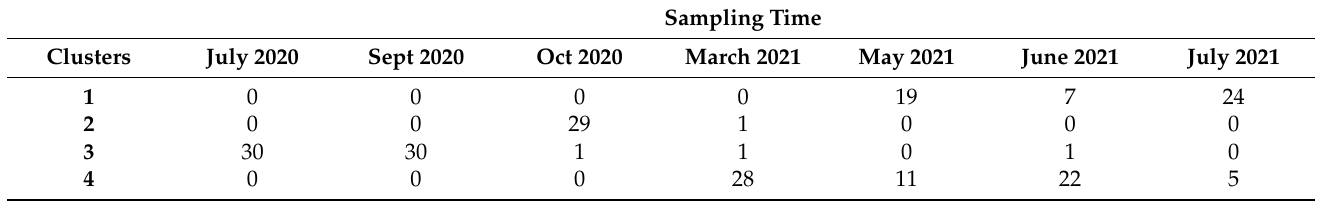
Figure 3. K-means clustering based on principal component values using relative abundance for 101 detected ASVs as the starting values. Different colors represent the different clusters. Table 4. Number of fecal samples collected at each sampling period stratified by cluster membership. Sampling